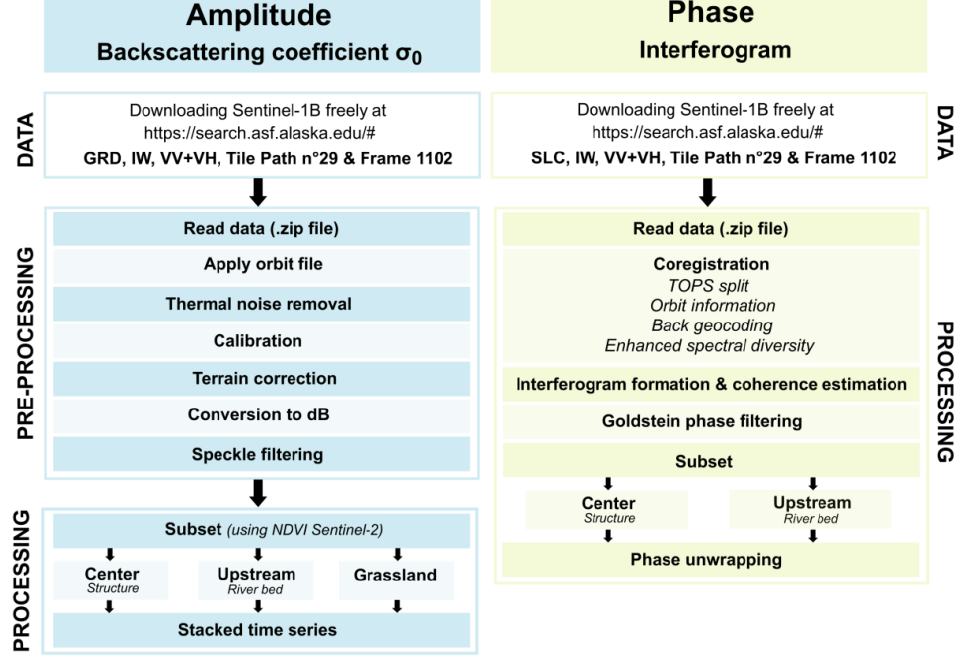
Figure 2. Flowchart of the processing steps for analysing both amplitude and phase of Sentinel-1 data. All the processing was done using SNAP (SeNtinel Applications Platform) software, version 8.0.0.